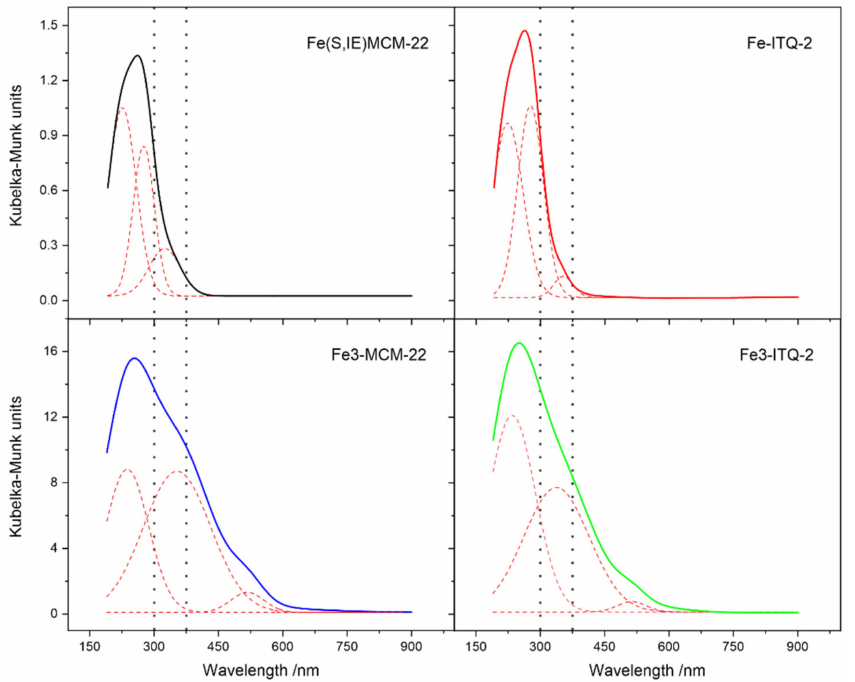
Figure 2. UV–vis-DR spectra of the MCM-22 and ITQ-2 samples modified with FeSO 4 · 7H 2 O and